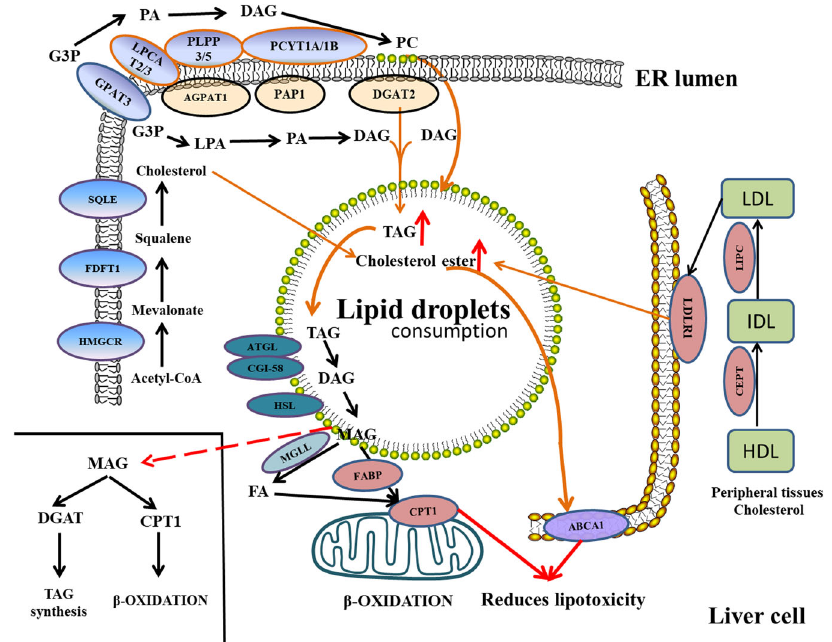
Fig. 3 Formation and maintenance mechanisms of lipid droplets in the liver of yellowstripe goby. Genes include GPAT3 , PAP , DGAT2 in TAG synthesis; FDFT1 , SQLE , LIPC , LDLR1 in CHOL synthesis; LPCAT3 in phospholipid synthesis; MGLL, CPT1, and ABCA1 in maintaining the balance between liver high-fat storage and